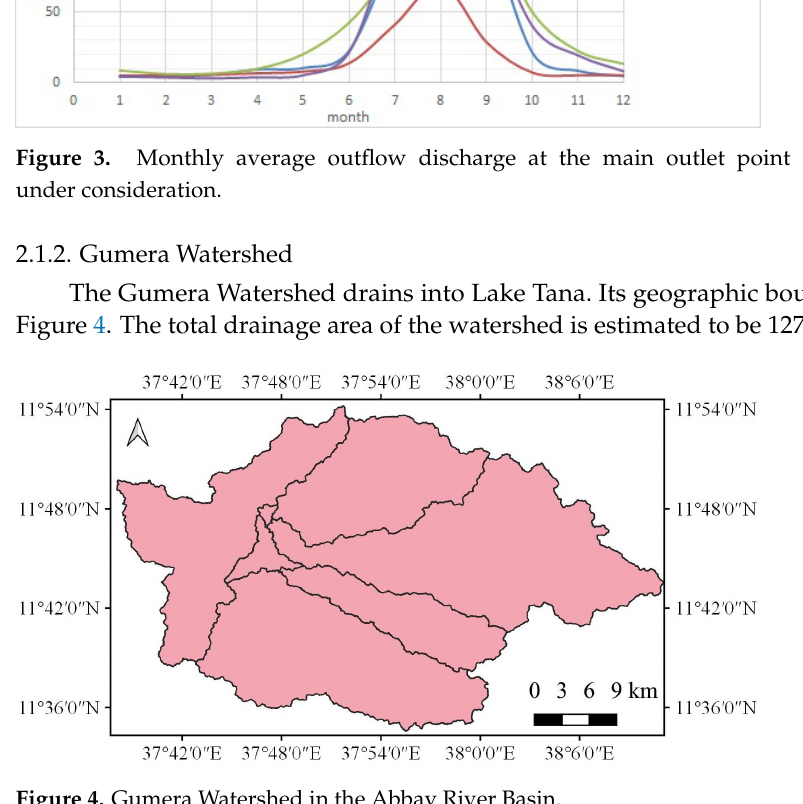
Figure 4. Gumera Watershed in the Abbay River